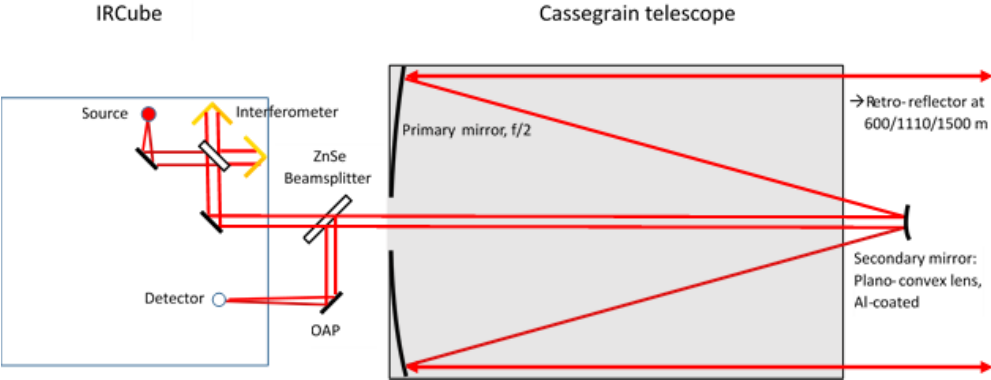
Figure 1. Schematic diagram of the setup of the OP-NIR spectrometer, its coupling to the Cassegrain telescope, and the light path through these and subsequent to/from the